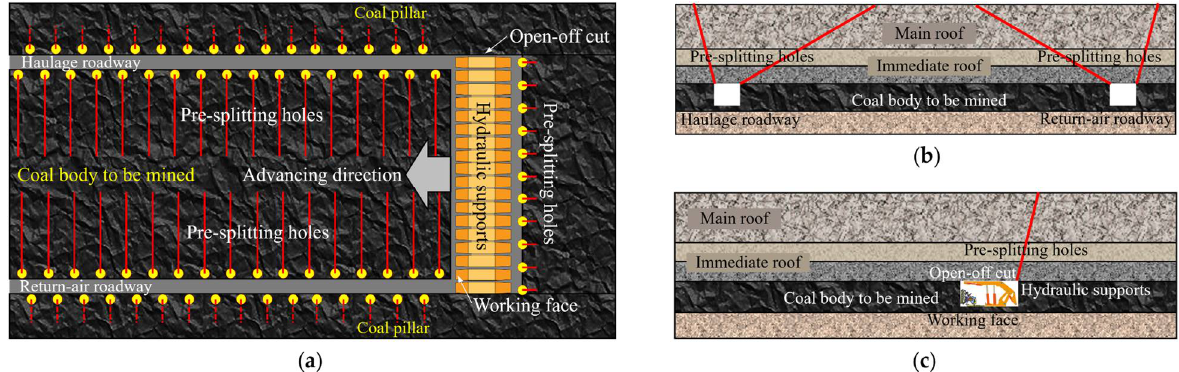
Figure 14. Fracturing operation of the thick and hard main roof. ( a ) Plane diagram of pre-splitting drilling hole ( b ) Side view of boreholes in roadway ( c ) Side view of boreholes in the open-off cut.